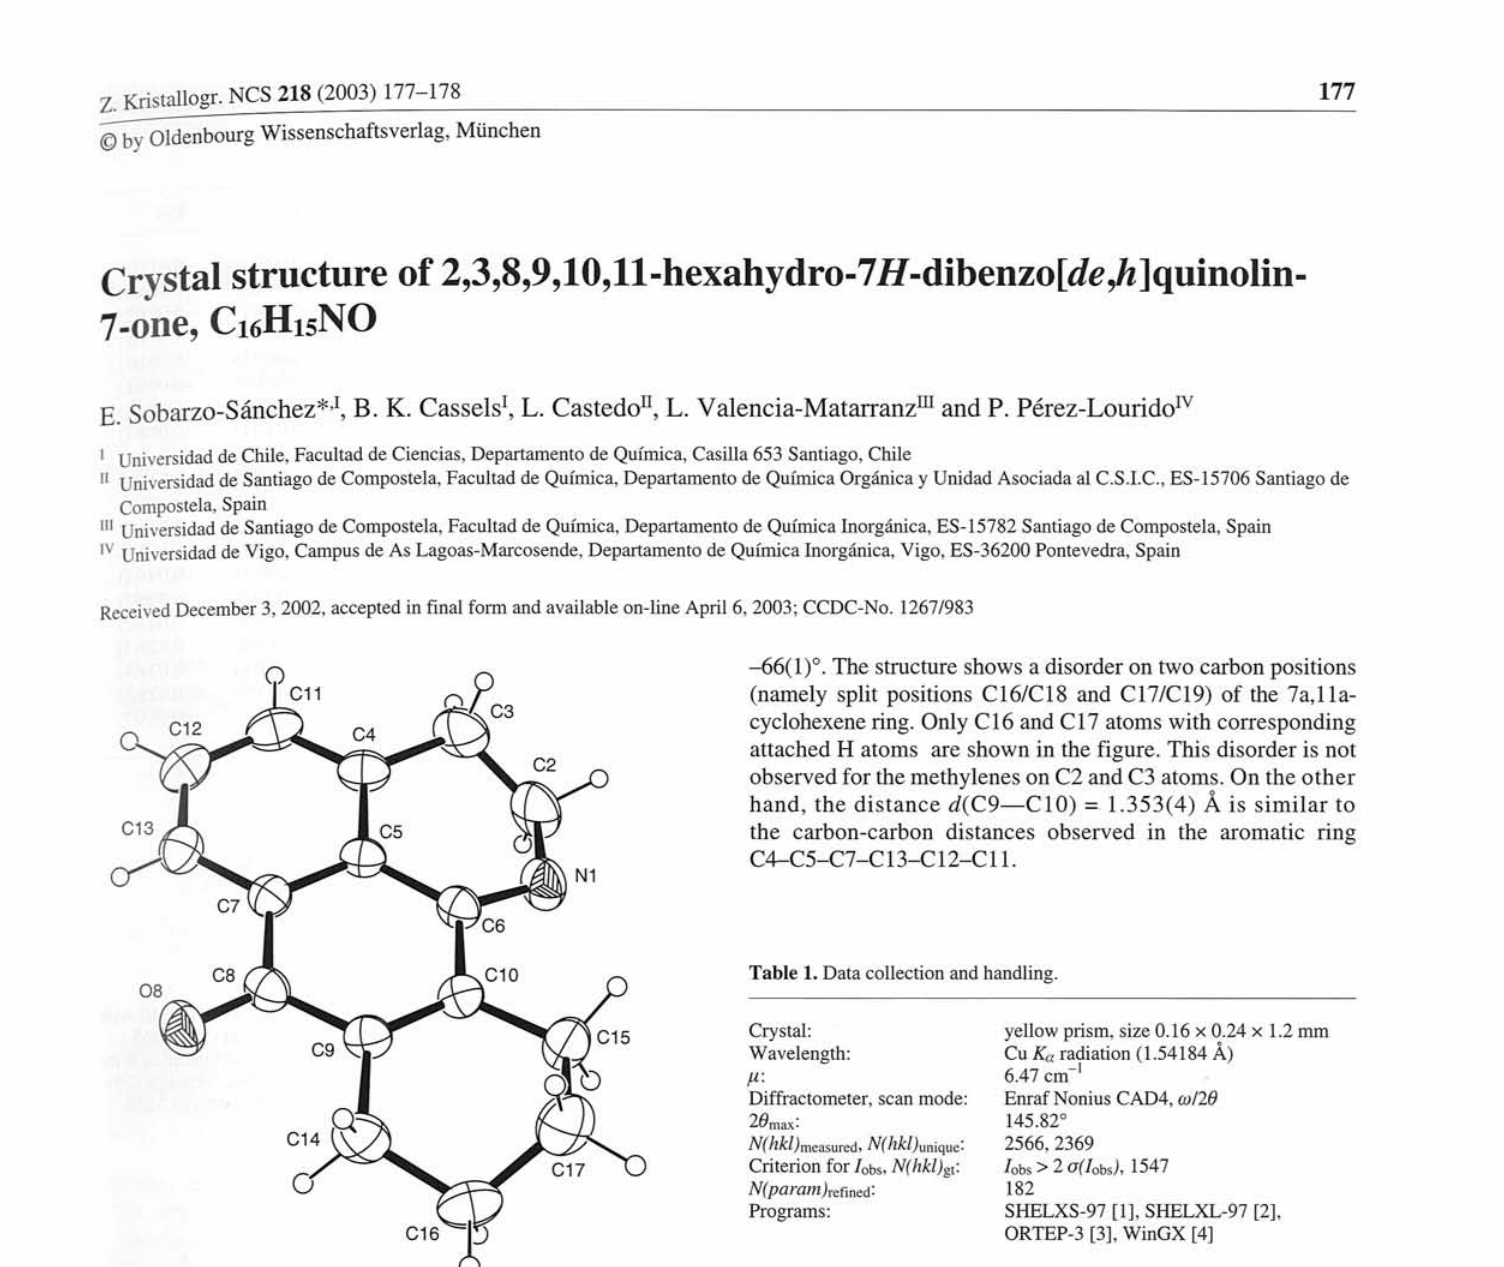
Table 2. Atomic coordinates and displacement parameters (in